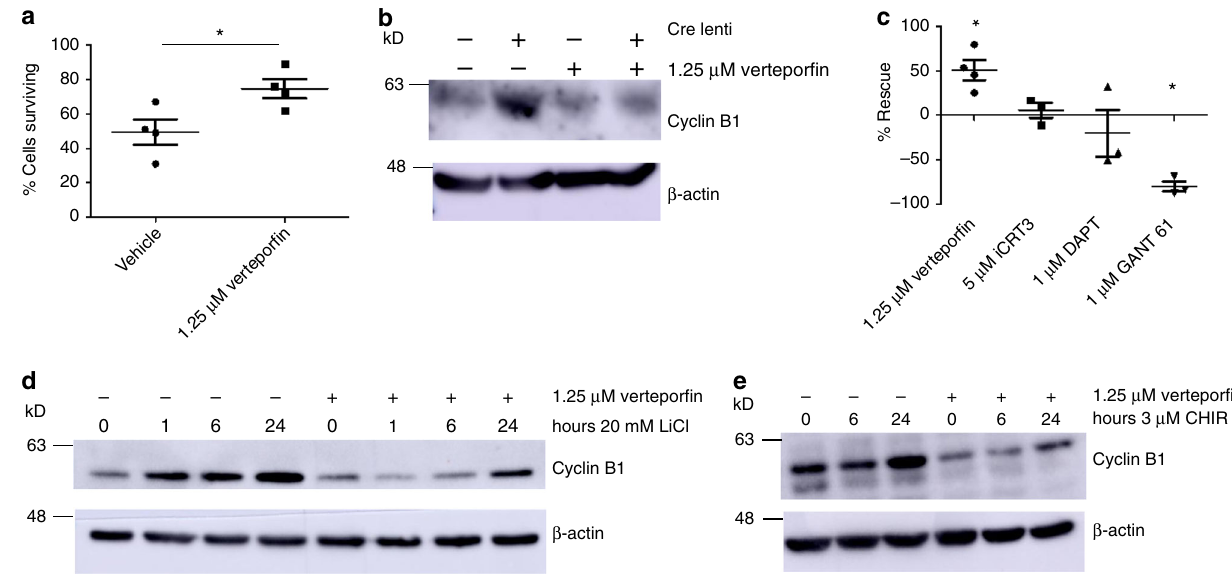
Fig. 8 Vertepor fi n attenuates the effects of GSK3 loss in cultured podocytes. a Inhibiting YAP/TAZ activity in the nuclei of cipodGSK3DKO cells with vertepor fi n improves cell survival. n = 4 independent experiments, unpaired two-tailed t test, * p < 0.05. See also Supplementary Fig. 10a. b Representative western blot showing that increased expression of Cyclin B1 in ciGSK3DKO cells is reduced by vertepor fi n, n = 3 experiments. See also Supplementary Fig. 10b. c Comparison of the effect of signalling pathway inhibitors on cipodGSK3DKO cell survival compared with vehicle. Inhibition of Wnt signalling with iCRT3 and Notch signalling with DAPT have no effect on cell survival while inhibition of Hedgehog signalling using GANT 61 signi fi cantly increases cell death (unpaired two-tailed t test * p < 0.05, n = 3 experiments except vertepor fi n n = 4 experiments). d , e Representative western blot of wild-type mouse podocytes incubated for 24 h with 20 mM LiCl or 3 μ M CHIR99201 showing that Cyclin B1 accumulation is reversed by treatment with 1.25 μ M vertepor fi n, n = 3 experiments. See also Supplementary Figs. 10c and d. Data are presented as the mean ±